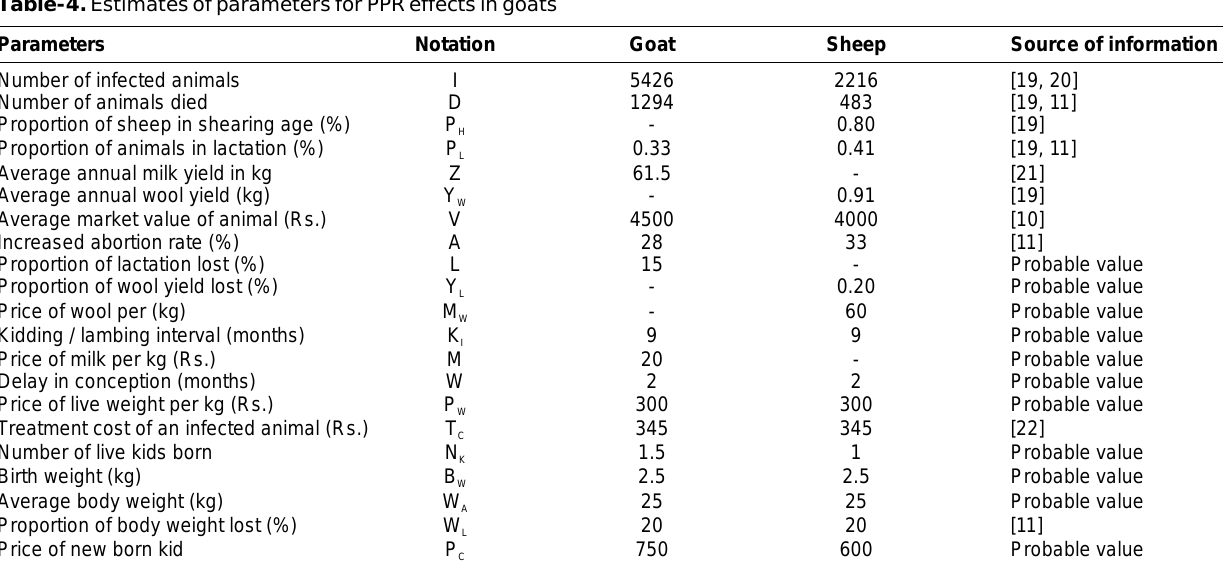
Table-4. Estimates of parameters for PPR effects in goats